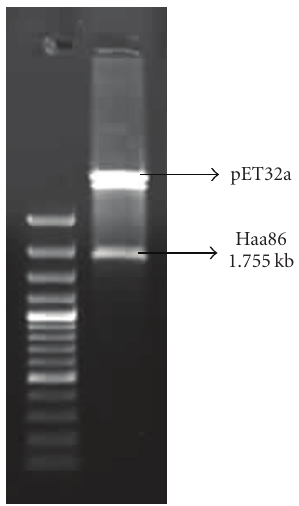
Figure 1: Release of insert after restriction digestion with EcoRI and XhoI. The 1.755 bp Haa86 gene was released by the restriction enzyme digestion